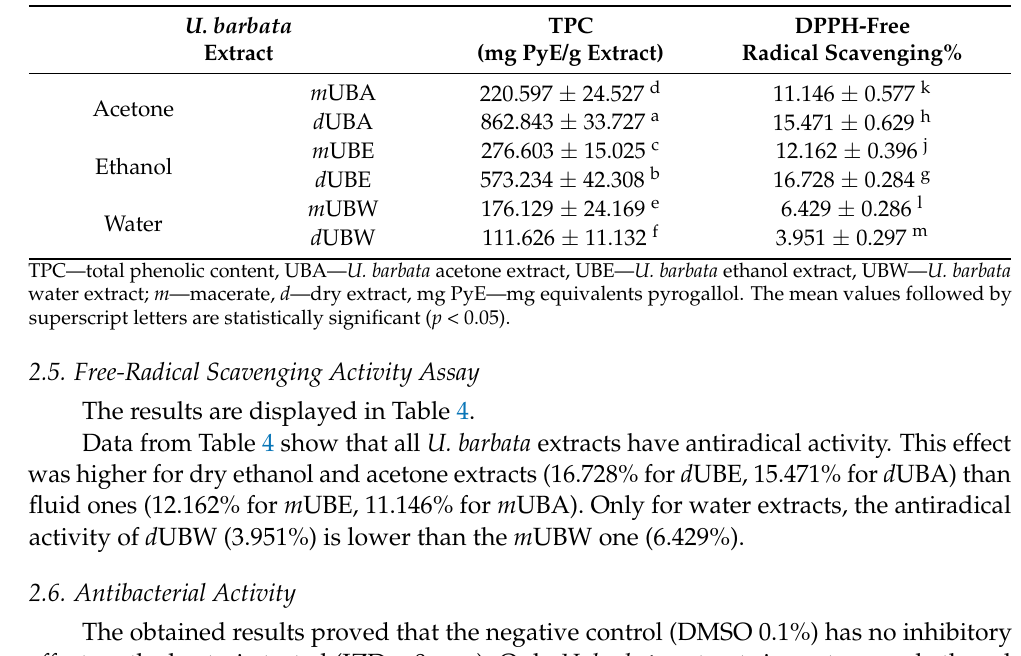
Table 4. Total phenolic content (TPC) and free-radical scavenging activity of U. barbata